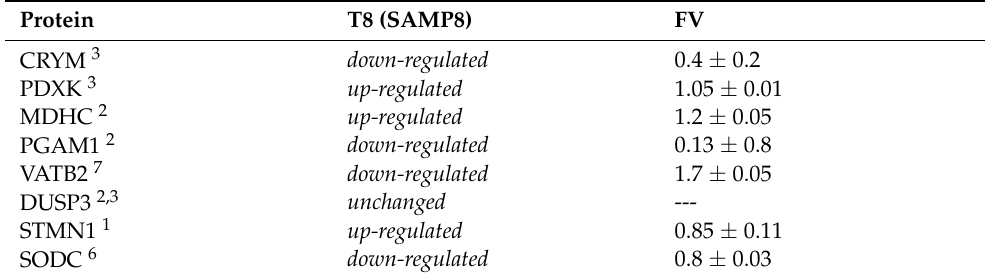
Table 4. Neuroproteome changes in 8-month-aged SAMP8.